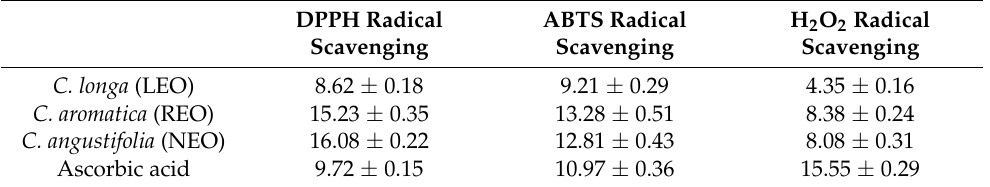
Table 3. Antioxidant activities of the Curcuma spp. leaf essential oils—expressed as IC 50 ( µ